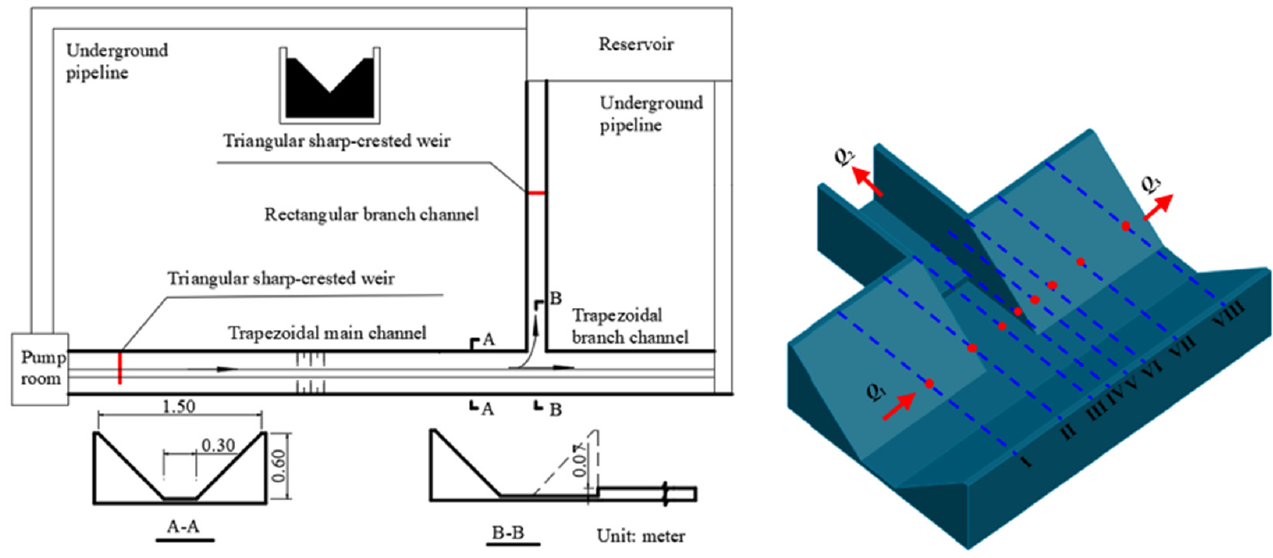
Figure 1. Experimental plan and section measurement layout. Note: Red points in the figure represent the measurement point arrangement, and Roman numerals represent measurement section numbers.